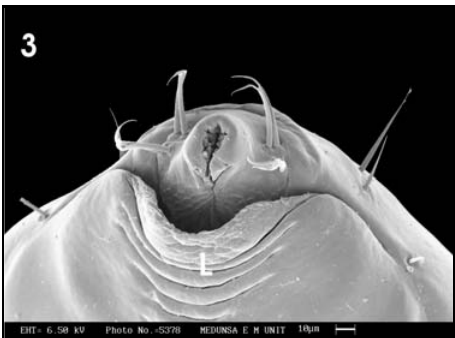
Fig. 3. The labrum (L) was folded in a membranous